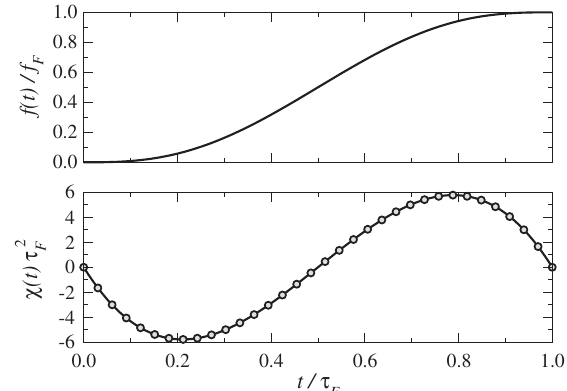
FIG. 2. Shortcut to adiabatic transport by local counter- diabatic driving. Whenever the trapping potential U ð q ; t Þ ¼ U 0 ½ q − f ð t Þ ˆ n (cid:1) [with γ ð t Þ ¼ 1 ], the auxiliary counterdiabatic ̈ f ≕ f χ ð t Þ induces the self-similar evolution term with F ¼ − F F Φ ð t Þ ¼ U Ψ ð t Þ , which at t ¼ f 0 ; τ reduces to Ψ ð t Þ ¼ Φ ð t Þ , and F g the auxiliary term vanishes. CD guarantees that the density profile of the system is centered at all times at q ¼ f ð t Þ ˆ n . This protocol holds exactly for an arbitrary trapping potential U 0 ð q Þ and is valid for an arbitrary single-particle, nonlinear, or many-body system, requiring no modulation of the coupling constant ϵ ð t Þ in the case of interacting systems, i.e., ϵ ð t Þ ¼ 1 . − m ̈ γ ¯ q 2 = γ ∝ τ − 2 = 2 Þ , the gain in the . In an early stage ð 0 ; τ F i F speed-up of the nonadiabatic expansion is provided by the auxiliary inverted harmonic potential, when ̈ γ > 0 ; see Fig. 3. The quickly expanding cloud is then slowed down = 2 ; τ ( ̈ γ < 0 ) by the CD term during the time interval ð τ Þ , F F and it comes to rest as the CD term vanishes ( ̈ γ → 0 − ), and the completion of the process is approached as t → τ . F